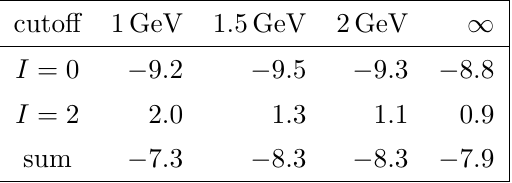
2) (cid:22) in units of 10 (cid:0) 11 . The cuto(cid:11) (cid:0)